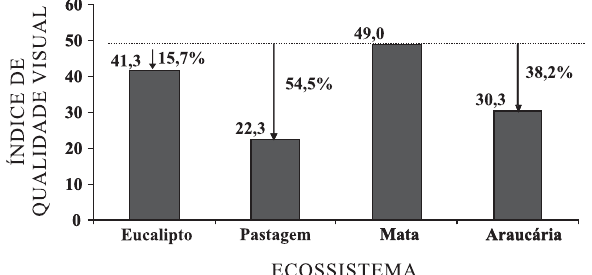
Figura 1. Índices de qualidade visual nos diferentes ecossistemas de estudo, obtidos por meio de atributos da qualidade do solo, fauna e vegetação. As setas indicam os respectivos déficits dos valores (em percentagem) dos ecossistemas com relação à referência